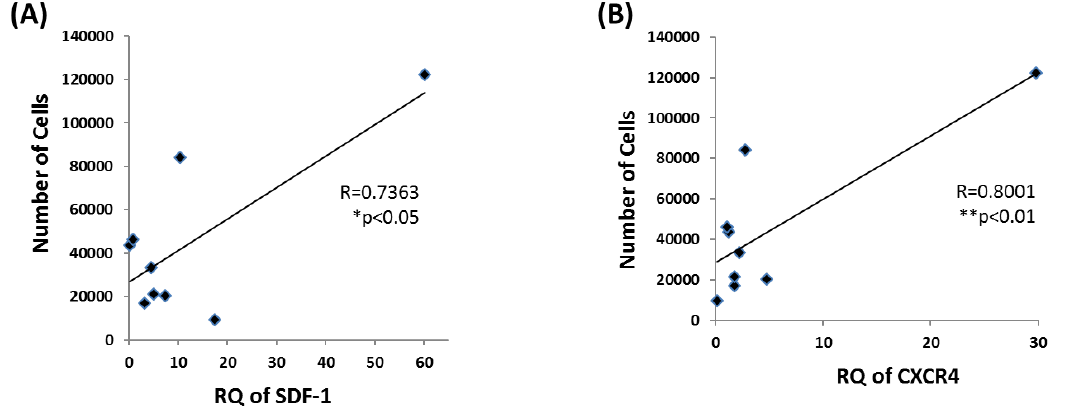
Figure 5. Correlation between EPCs proliferation rate and SDF-1 and CXCR4 genes. Cell number after 48h demonstrated a positive correlation with expression levels of ( A ) SDF-1 gene, R = 0.8001 ** p < 0.01, and ( B ) CXCR4 gene, R = 0.7373 * p <